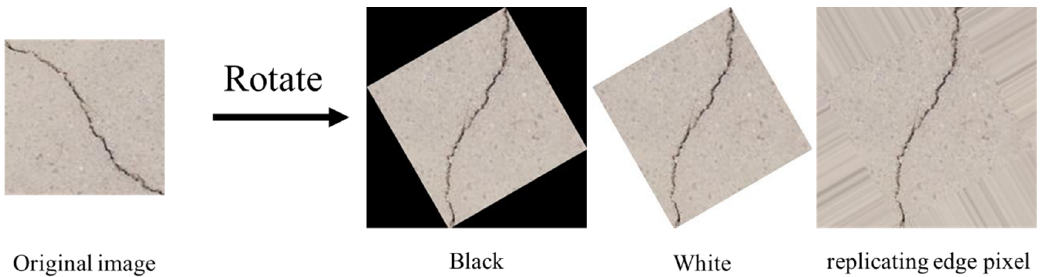
Figure 7. Three padding modes. ( 0.8 ) Table 2. F of the models trained with rotation for data augmentation adopting di ff erent padding ext